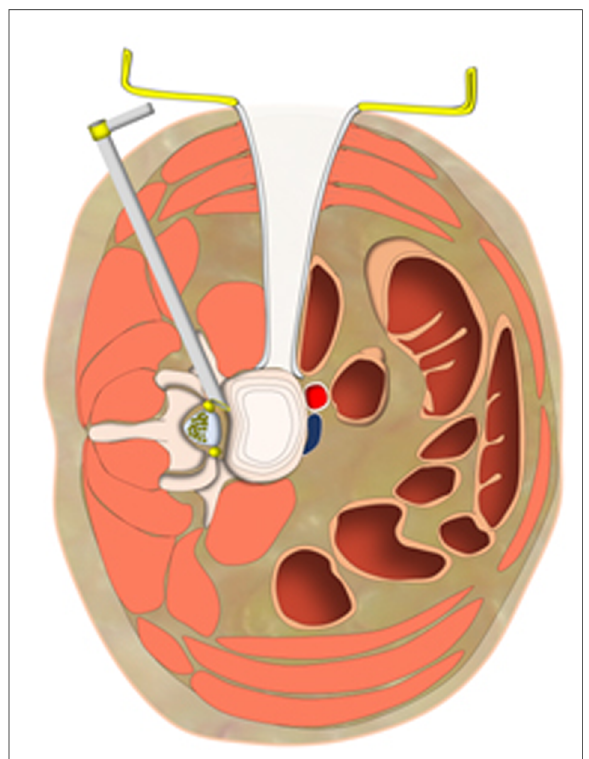
FIGURE 6 Posterolateral approach of PTES and anterolateral approach of OLIF meet with each other at posterior longitudinal ligament and annulus fi brosus of disc. PTES, percutaneous transforaminal endoscopic surgery; OLIF, oblique lumbar interbody